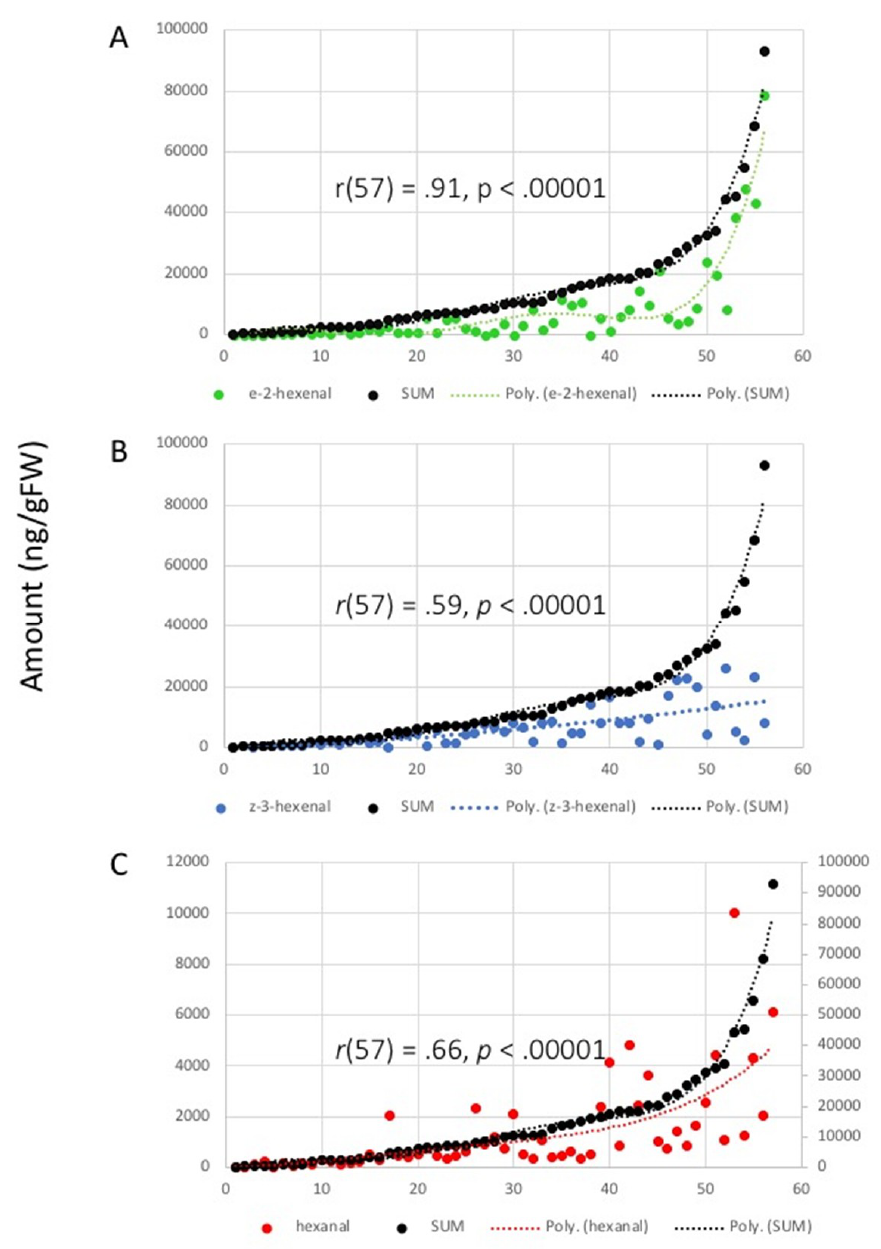
Figure 4. Correlation between total amount of green leaf volatiles and individual compounds after damage. ( A ) correlation of ( E )-2-hexenal with total amount; ( B ) correlation of ( Z )-3-hexenal with total amount; ( C ) correlation between hexanal and total amount. Note that, for hexanal ( C ), a separate scale was used due to the large difference in produced amounts. Correlation coefficients ( r ) and p -values are shown on the graphs. Trendlines are shown in corresponding colors (dotted lines). Results for each plant are averages from at least three biological replicates.